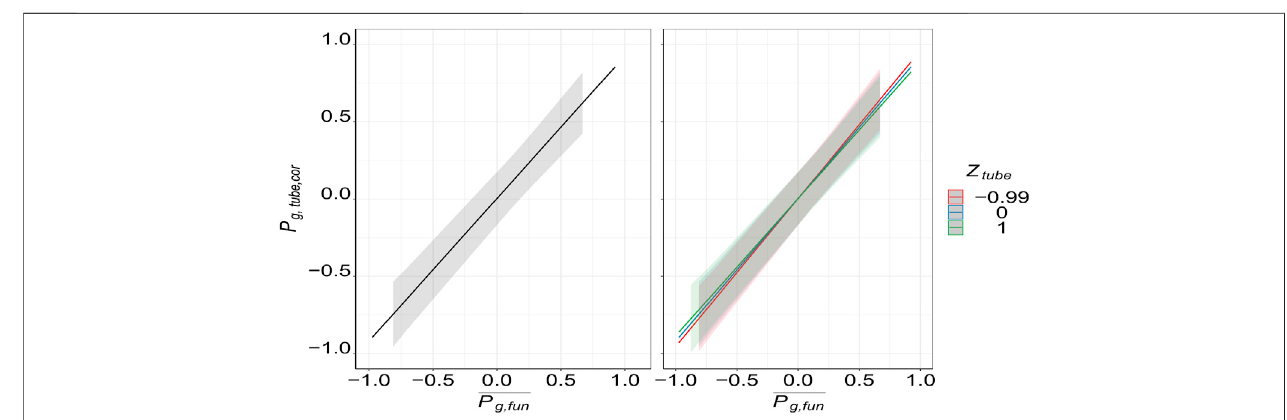
Frontiers in Earth Science |